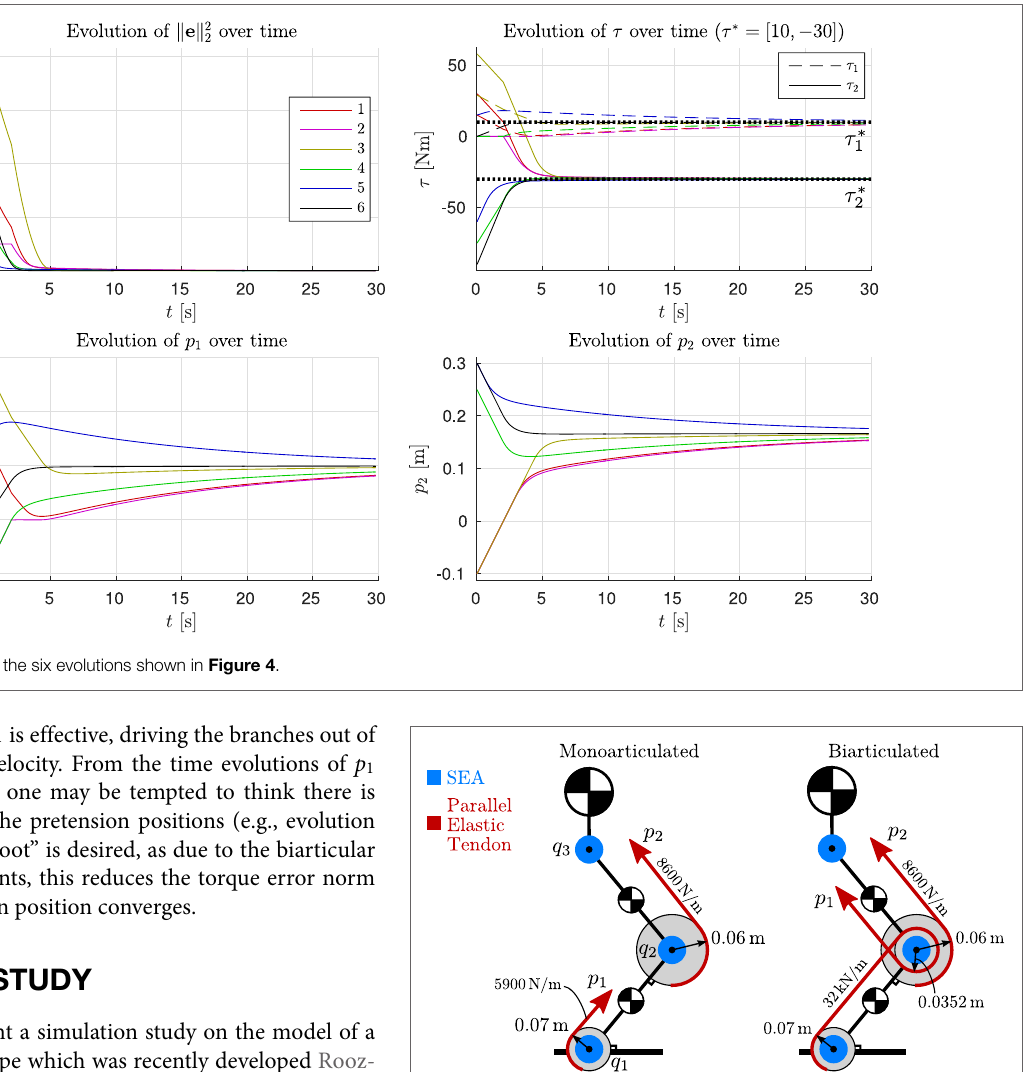
FIGURE 6 | 3-DoF leg model used in simulation, shown in both mono- and biarticulated actuation configurations. ankle and knee joints. The design parameters were